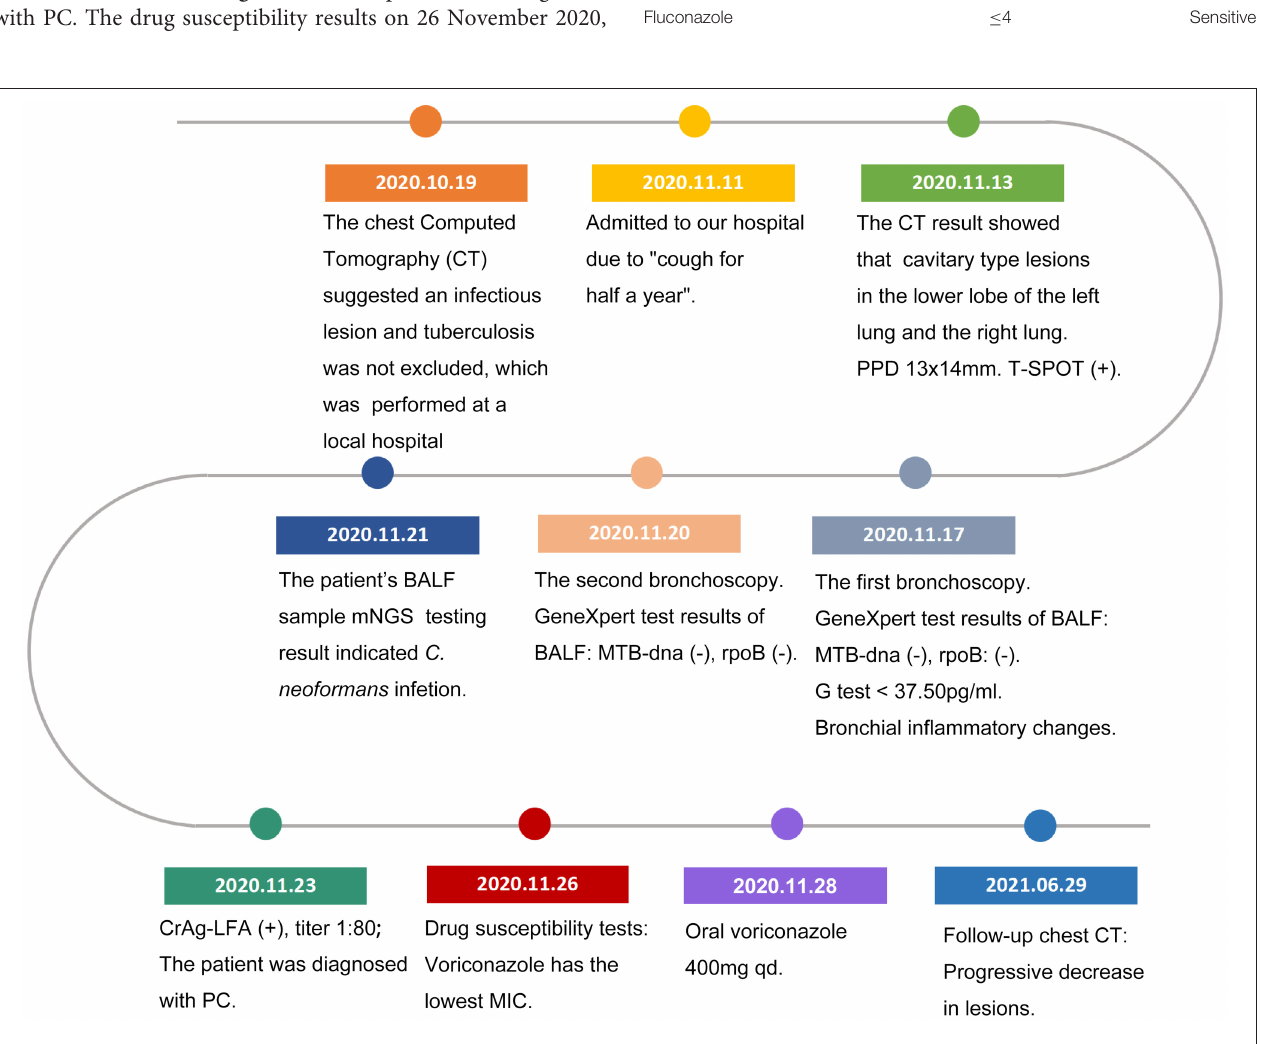
FIGURE 4 | Timeline of the reported